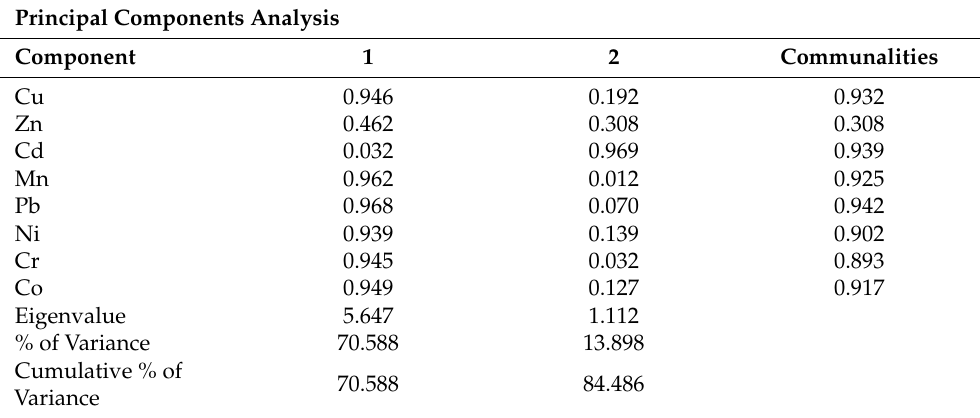
Table 8. Output of principal components analysis, eigenvalues, percentage of variance, and cumula- tive percentage of